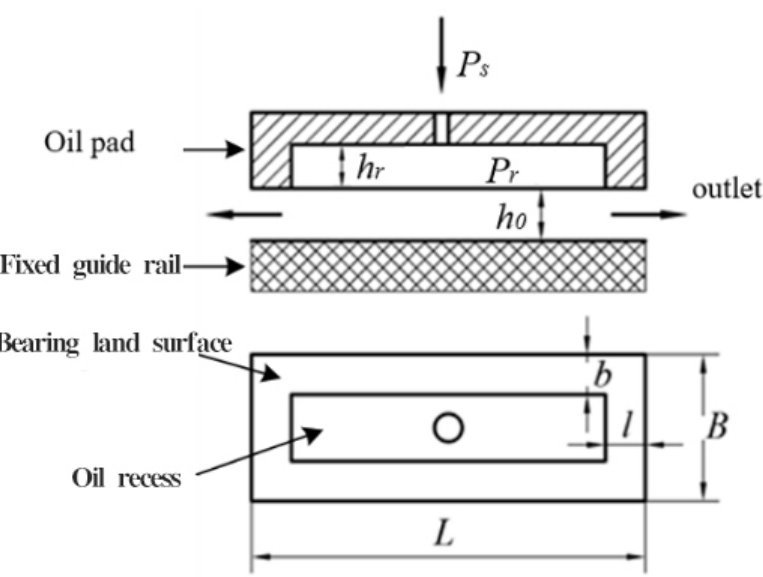
Figure 2. Schematic diagram of structural parameters. The lubricant Mobil-Velocite-10 was selected to reduce system temperature. To reduce recess deformation, a lower recommended value of recess pressure was adopted. The bear- ing width was selected according to the maximum supporting load capacity. The seal band width was selected at the minimum power consumption. In order to increase the bearing stiffness, a smaller recess depth was selected within the optional range. The detailed param- eters are shown in Table 1 and a three-dimensional structure for the experiment is shown in Figure 3. At the top of the model, there is a spherical hinge constraint, which ensures that the structure can be rotated at will around the center of the ball. In the experiment, oil is injected from the oil inlet and flows through the right-hand orifice into the oil recess. Underneath the oil recess, an oil sealing surface is used to seal the oil.